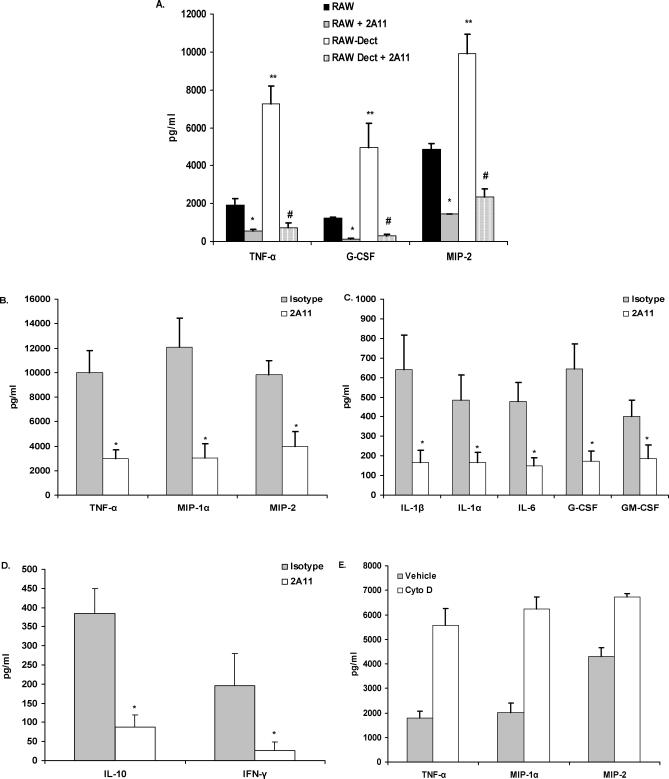
Dectin-1 Dependent Cytokine and Chemokine Production in Response to A. fumigatus
(A) Native RAW 264.7 macrophages or RAW 264.7 over-expressing murine dectin-1 were pretreated with isotype or 2A11 and co-cultured for 24 h with live A. fumigatus. Supernatant cytokine and chemokine levels were determined by Bio-Plex or ELISA. (A) illustrates cumulative results from five separate experiments. Asterisks, double asterisks, and the hash sign represent significant differences between RAW and RAW + 2A11, RAW and RAW-Dect, and RAW-Dect and RAW-Dect + 2A11, respectively (p < 0.05). Data are expressed as mean pg/ml + SEM.(B–D) Identical experimental design with alveolar macrophages. (B–D) illustrate cumulative results from five separate experiments. Asterisks represent significant differences between isotype and 2A11 (p < 0.05). Data are expressed as mean pg/ml + SEM.(E) Alveolar macrophages were pre-treated with 10-μM cytochalasin D and co-cultured with live A. fumigatus for 16 h. Supernatant cytokine and chemokine levels were determined by Bio-Plex or ELISA. (E) illustrates cumulative results from three separate experiments. Data are expressed as mean pg/ml + SEM.